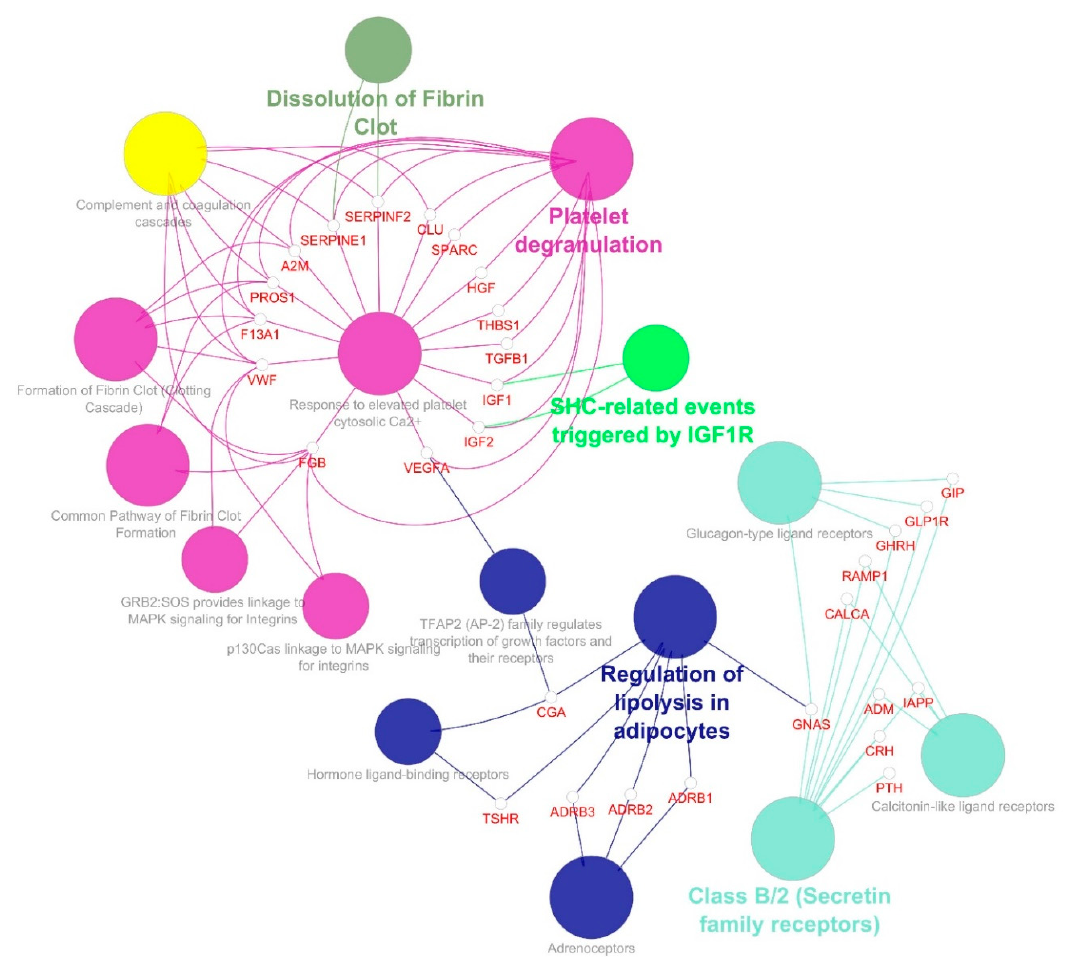
Figure 6. Molecular enrichment networks of genes associated with diabesity and the cluster 2 network enrichment analysis. Visualization of GO gene enrichment profiling using Cytoscape on the basis of ClueGO/CluePedia network processing deciphered from cluster 2. A combination cluster enrichment analysis, such as the GO BF, MF, and KEGG pathway, was provided by the plugin. GO term network connectivity identified by gene-shared edges and cohesive clusters (kappa score ≥ 0.4) and showing pathways ( p -value ≤ 0.05). The node size indicates the p -value. The color code of nodes corresponds to the functional group to which they belong. Bold colored characters signify the most essential functional terms which define the pathways within each class. Each node constitutes a precise term for cluster 2.